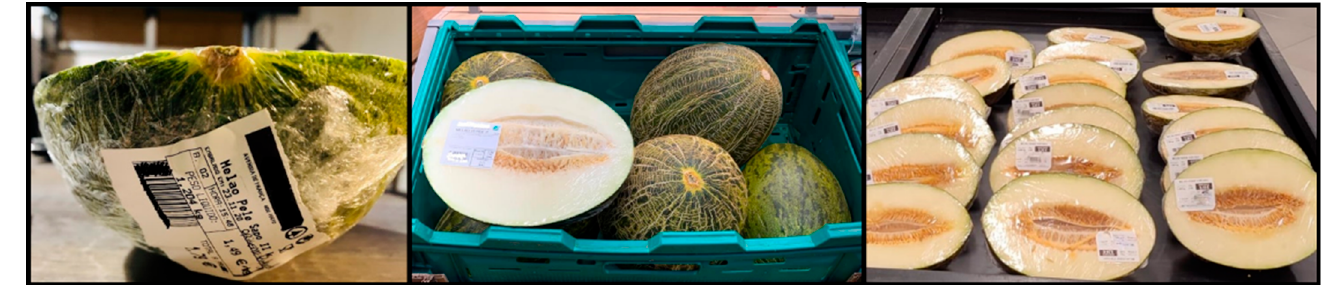
Figure 1. Cut and wrapped melons for sale at the fruit